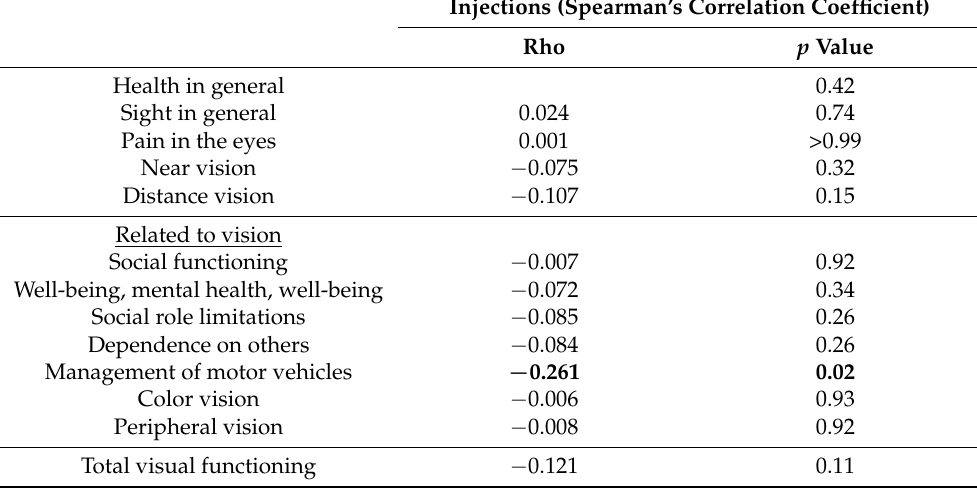
Table 6. Correlation of visual functioning with the number of drug applications (Spearman’s correla- tion